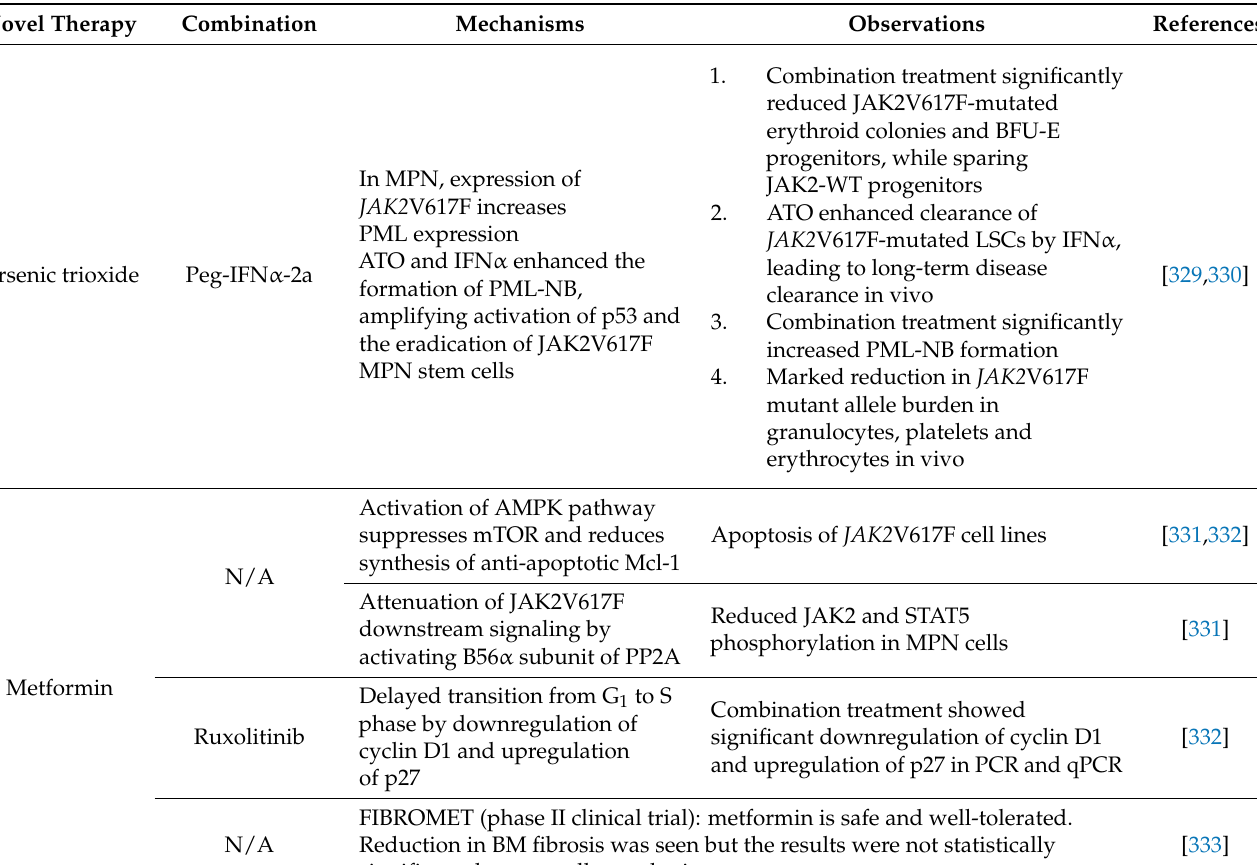
Table 5. Other potential therapeutic targets in MPN in preclinical